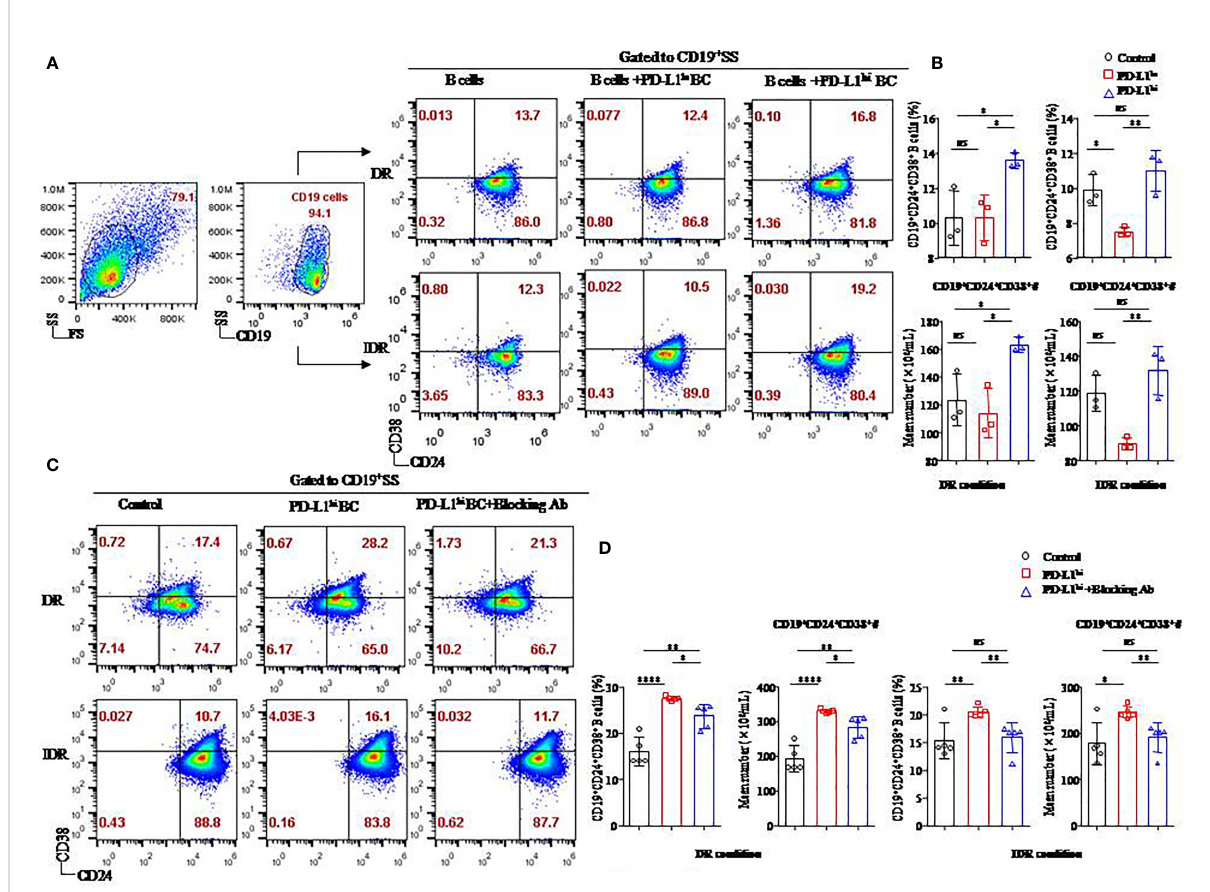
FIGURE 5 The soluble form of PD-L1 originating from a breast cancer cell line induced CD19 + CD24 + CD38 + Bregs in coculture systems. Representative fl ow cytometry dot plot of CD24 and CD38 expression in total CD19 + B cells cultured with PD-L1 hi MDA-MB231 cells or PD-L1 lo MCF-7 cells in DR or IDR conditions (A) . The percentages and the absolute number of CD19 + CD38 + CD24 + B cells were detected in the culture systems with PD-L1 hi MDA-MB231 cells or PD-L1 lo MCF-7 cells in DR (n = 3) or IDR (n = 3) conditions (B) . Representative fl ow cytometry dot plot of CD24 and CD38 expression in total CD19 + B cells cultured with PD-L1 hi MDA-MB231 with or without PD-L1 – blocking antibody treatment in DR or IDR conditions (C) . The percentages and the absolute number of CD19 + CD38 + CD24 + B cells were detected in DR (n = 5) or IDR (n = 5) conditions with PD-L1 hi MDA-MB231 cells pretreated with or without PD-L1 – blocking antibody (D) . Data represent the means ± SEM of at least three independent experiments and were analyzed by Student ’ s t -test. ns, not statistically signi fi cant. * P < 0.05, ** P < 0.01, and **** P <